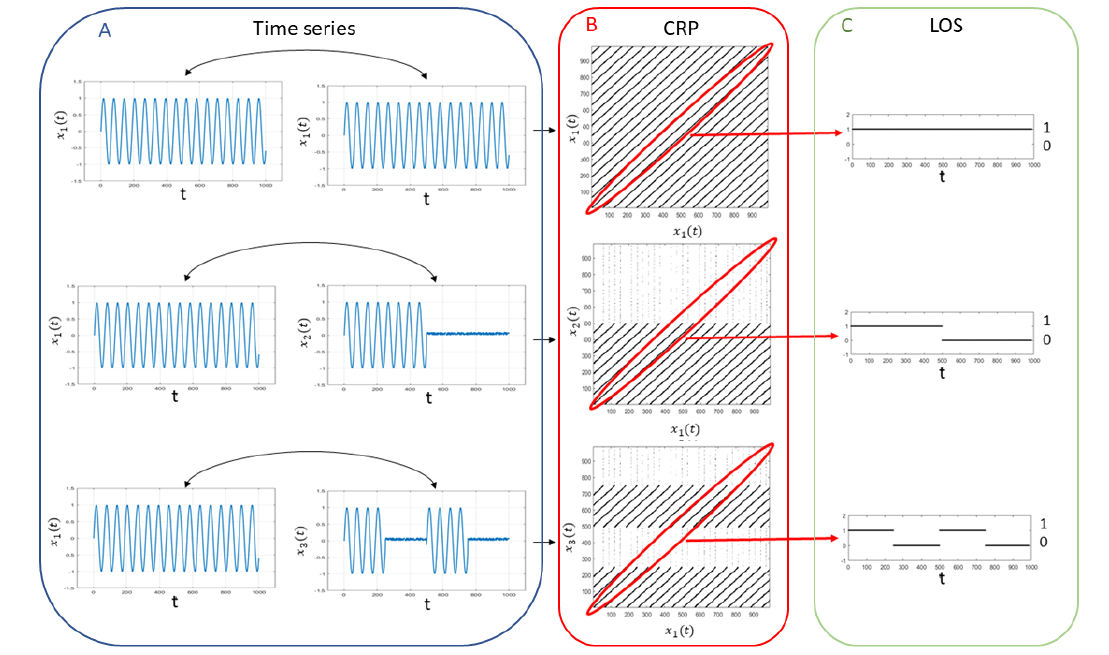
Figure 1. Example of synchronization quantification: for two fully synchronized sine waves (top panel A ), two sine waves synchronized for half of the observational period (middle panel A ) and two sine waves synchronized in intermittent way (bottom panel A ), the CRPs are computed by using the Takens’ theorem (panel B ) and the LOS is extracted from each plot (panel C ) in order to assess the SYNC